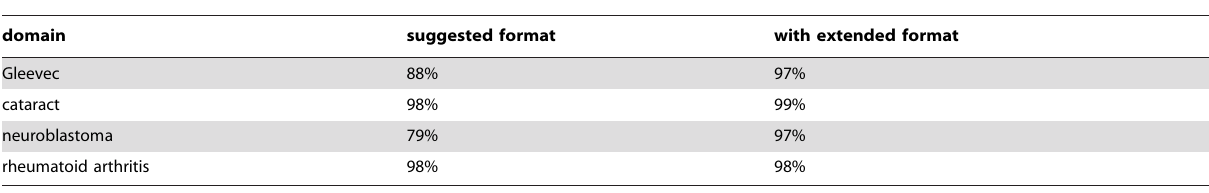
Table 2. Eligibility text format.